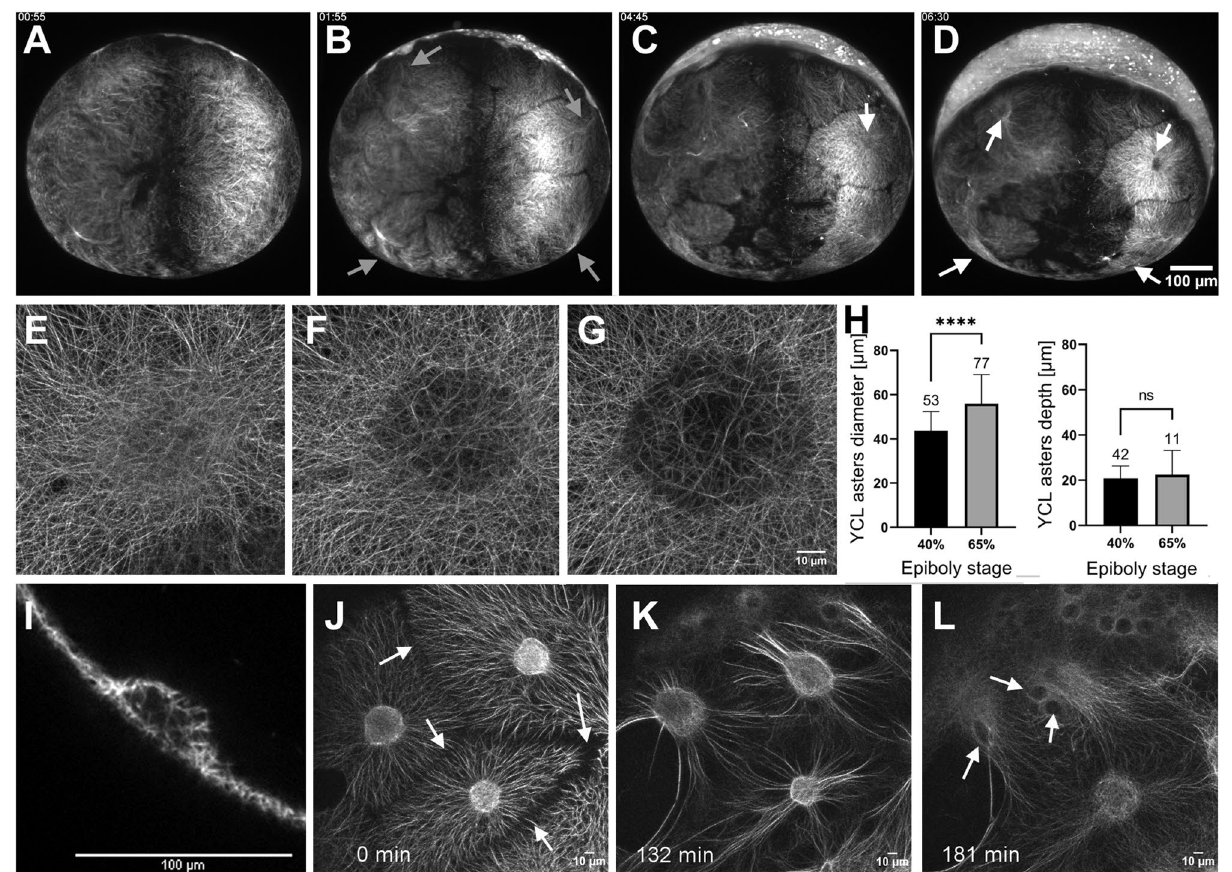
Figure 3. The YCL asters form and evolve throughout epiboly. ( A – D ) Embryo vegetal view. ( A ) Before epiboly, the MT network uniformly covers the exposed yolk. ( B ) At sphere stage, the MT network acquires a new configuration and rearranges into clear domains, with a central high dense MT bundle emanating from each of them (grey arrows). ( C ) Emerging from those bundles, defined MTs domains start migrating vegetally following a flat to hemisphere transition, leading to the formation of a visible YCL aster (white arrow) with radially oriented MT fibers in the middle of each domain ( D ) See Video S3. ( E – G ) High-resolution visualization of an aster formation through CSLM. See also Video S5. ( H ) After inspection of more than a hundred asters in different embryos we observe that, once formed, asters’ diameter increases with epiboly progression, while their depth remains constant. p-values: ****p < 0.0001, ns means p > 0.05. ( I ) A cross section of a YCL aster highlights its half-sphere shape. Aster’s dynamics are shown in Video S4 ( J ) The aster domains remain individualized with defined boundaries (white arrows), with clear opposing MT tips. ( K ) When the marginal blastoderm approaches the YCL asters (from the top left of the image), the MT network rearranges once again: thicker bundles are formed and reorient in the AV direction, and ( L ) the cores of the YCL asters actively migrate animalwards, concomitantly with eYSN undergoing epiboly (white arrows), until ( L ) they disappear underneath the YSL. See Videos S6 and